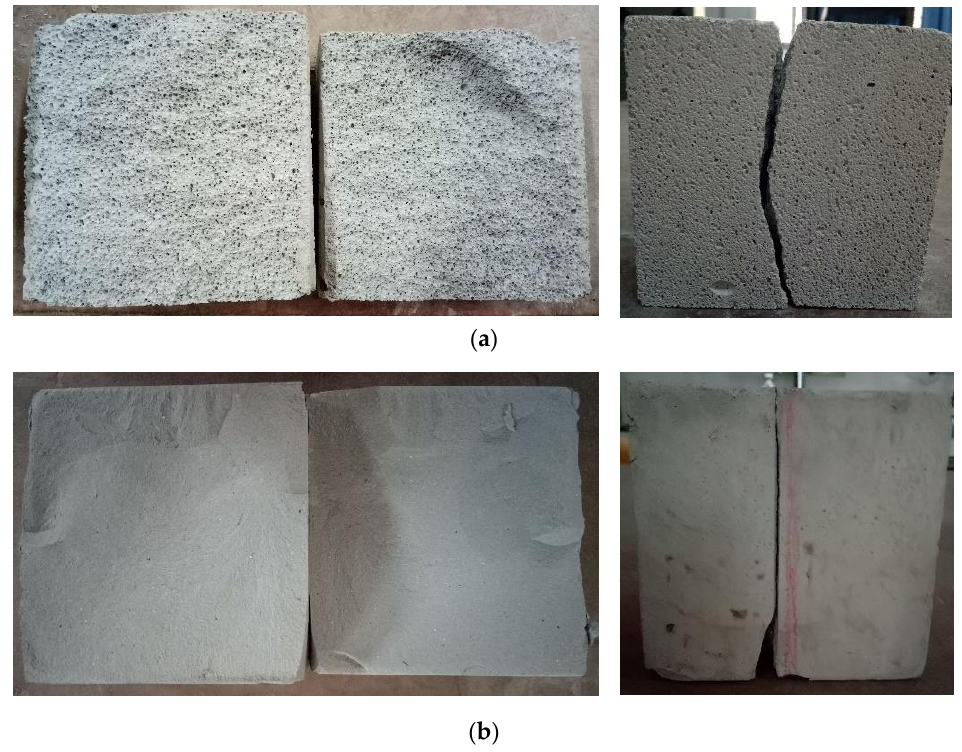
Figure 19. Failure pattern of splitting tensile strength: ( a ) AAC; ( b ) base material. Table 12. Test result of splitting tensile strength of AAC and base material.